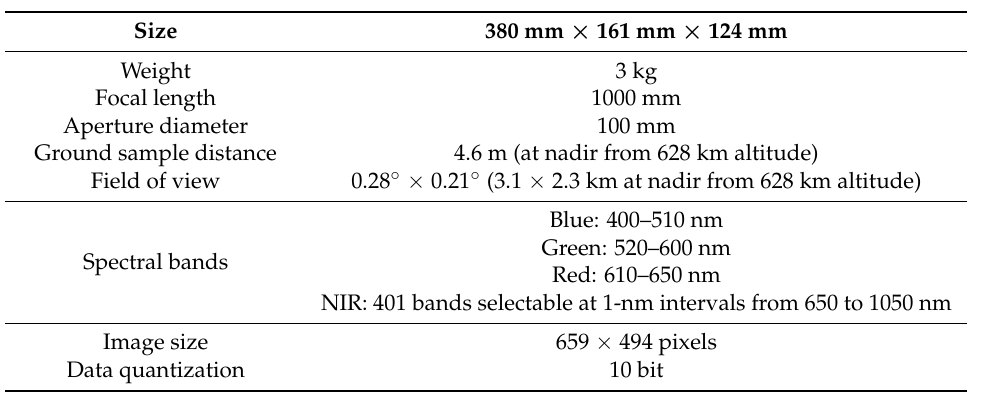
Table 1. Specifications of the